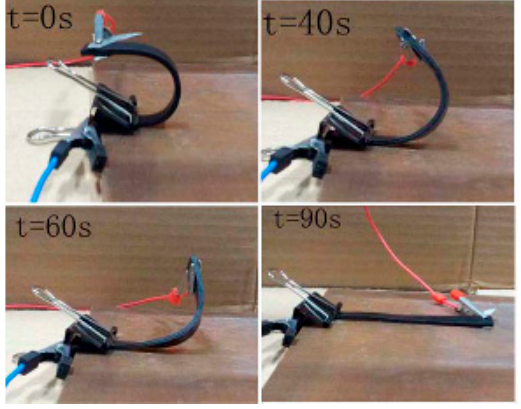
Figure 10. The shape recovery process of the sample with 2.0 wt % graphene under a voltage of 80 V.